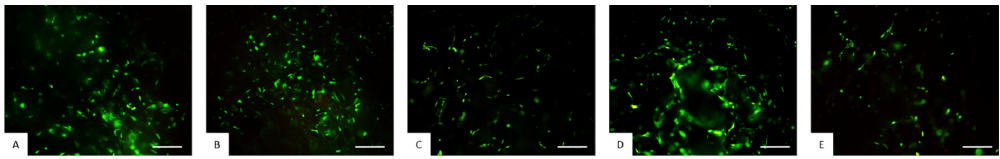
Figure 8. Cell viability analysis performed with the Live/Dead kit where the calcein acetoxymethyl (calcein AM) labels the living cells in green and ethidium homodimer-1 labels dead cells in red. The HMSCs seeded on ( A ) Gel; ( B ) CNFs; ( C ) GCN-50:50; ( D ) GCN-25:75; ( E ) GCN-75:25 — images taken 1 day after seeding. Scale bar: 200 µm.